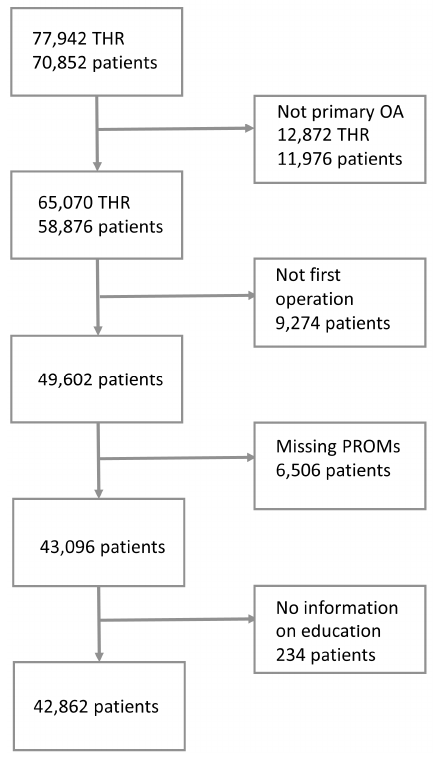
Figure 1. Flowchart study design. THR: total hip replacement; OA: osteoarthritis; PROMs: patient-reported outcome measures.